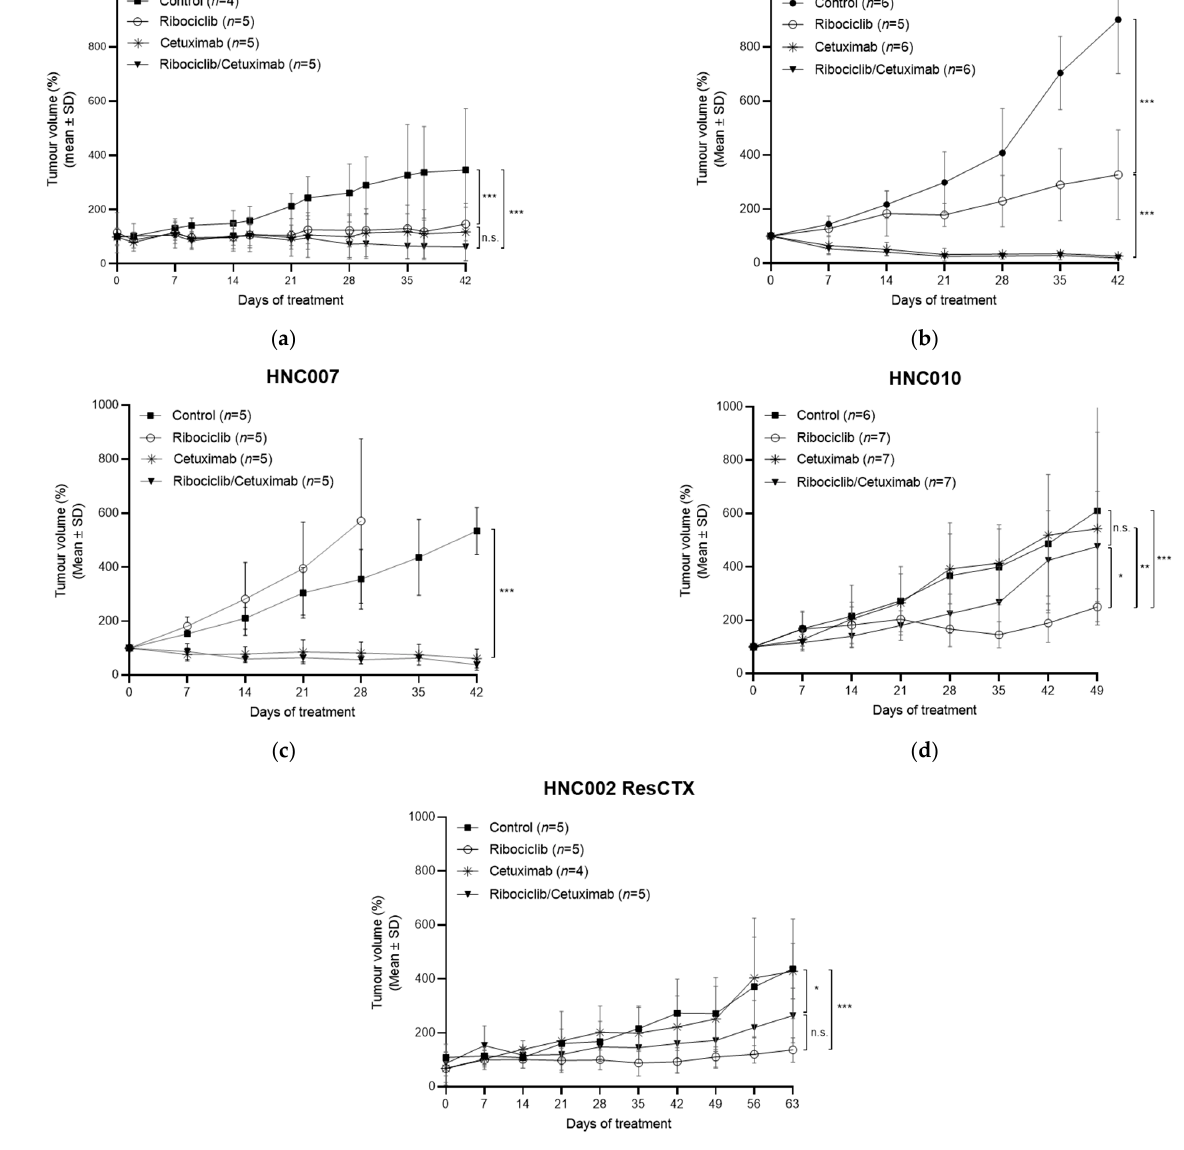
Figure 1. Ribociclib, cetuximab, and ribociclib/cetuximab activity were evaluated in three HPV-negative SCCHN PDTX models; ( a ) HNC002, ( b ) UCLHN01, ( c ) HNCOO7, ( d ), HNC010, ( e ) HNC002-ResCTX. Mice received daily 100 mg/kg ribociclib, or weekly 30 mg/kg cetuximab, a combination of ribociclib and cetuximab, or the vehicles. n.s. (no significance): p > 0.05; * p < 0.05; ** p < 0.001; *** p < 0.0001.